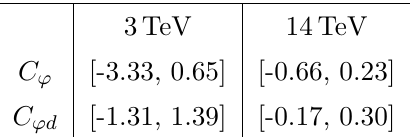
also shifts the HW W ’d ’d